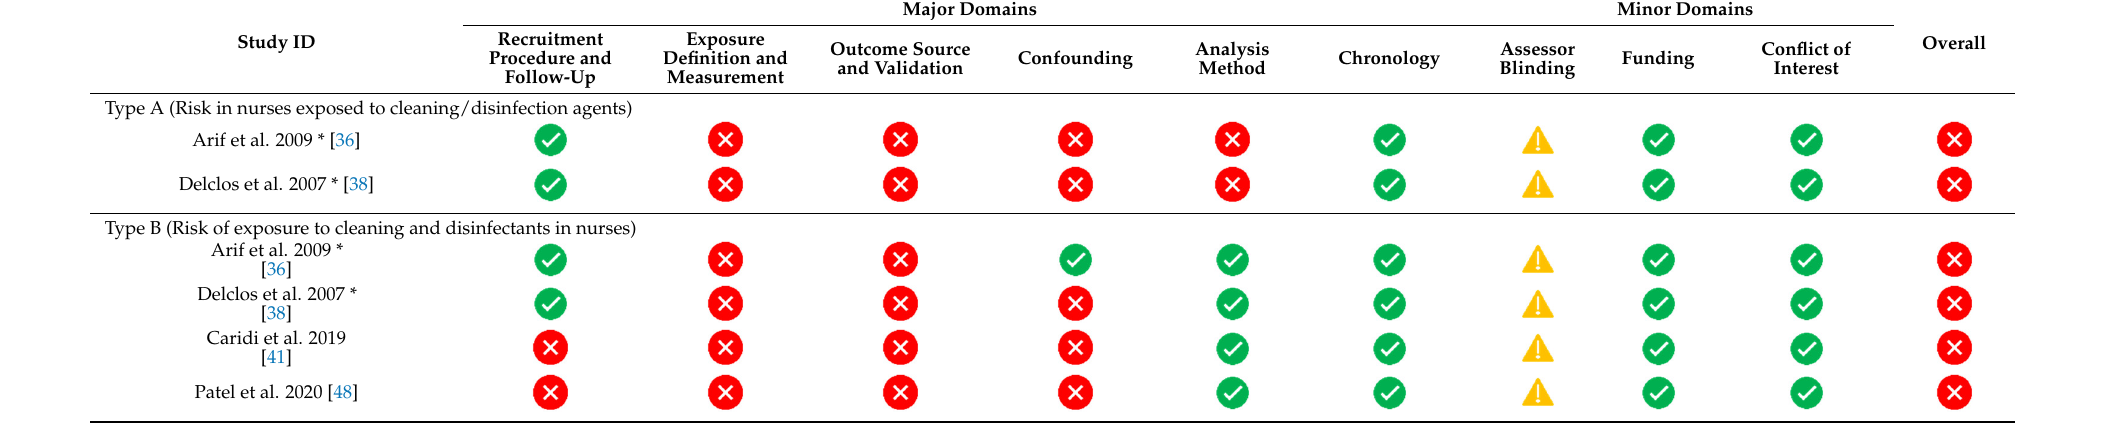
Table 2. Risk of bias for asthma studies.